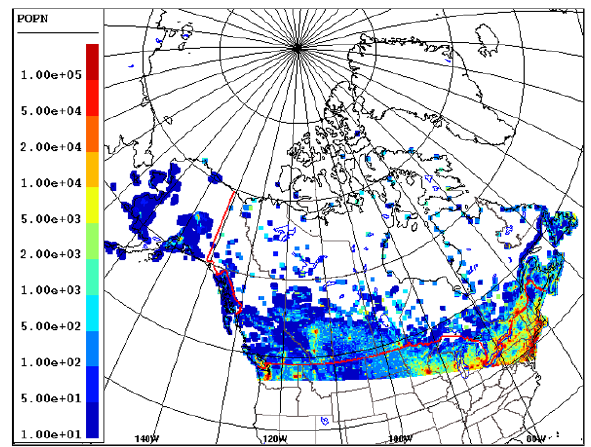
Figure 13. Gridded population based on 2010 US and 2011 Cana- dian census